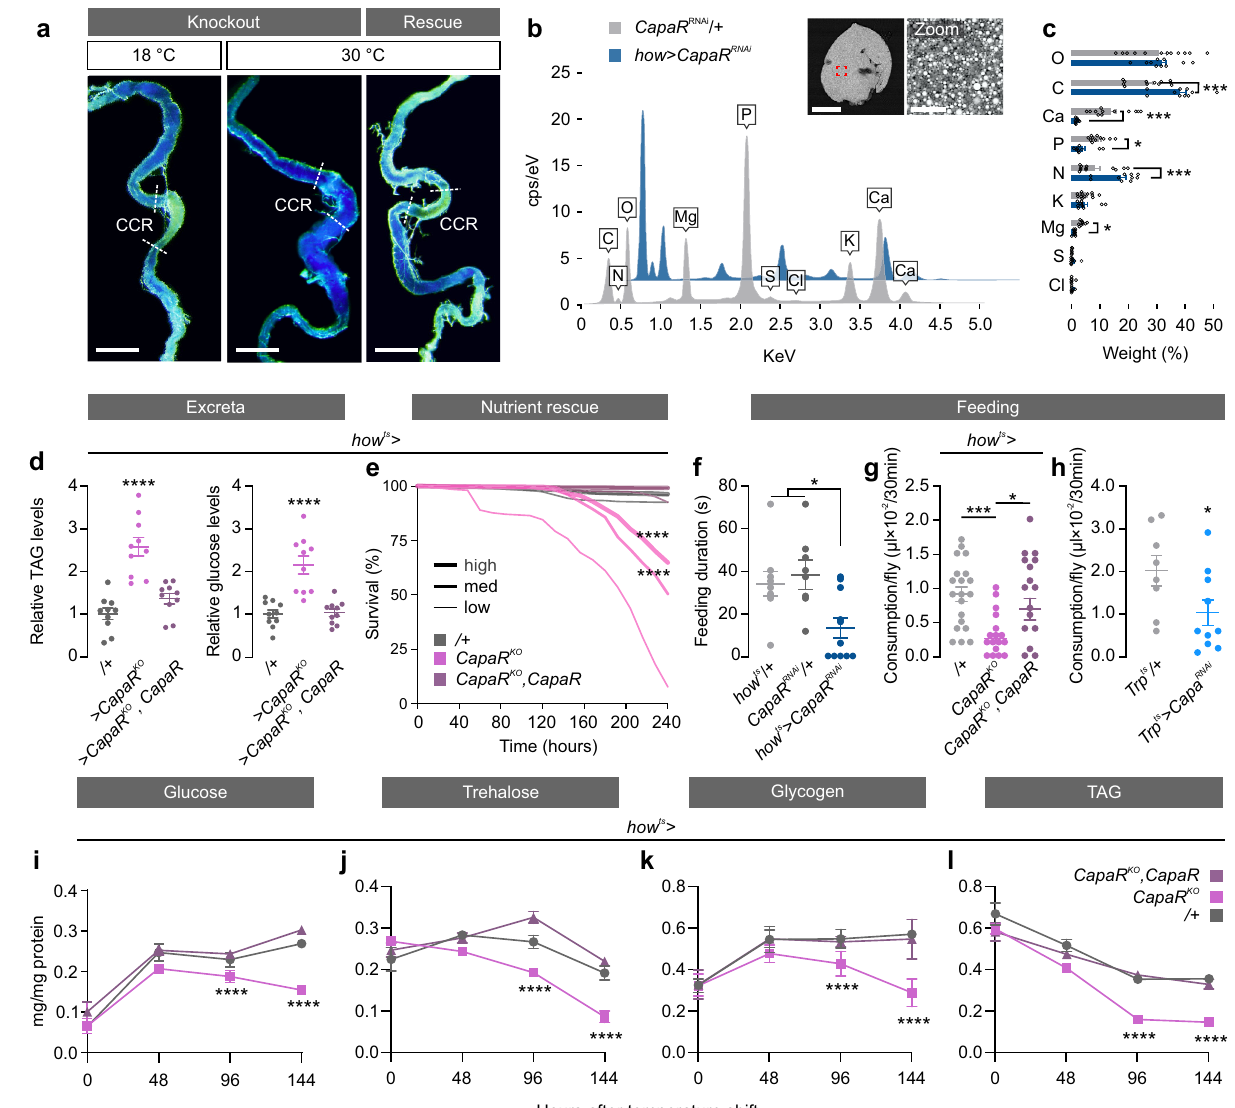
Fig. 5 CapaR deletion in visceral muscles causes systemic metabolic imbalance. a Dissected intestinal tracts from fl ies fed with food supplemented with the pH indicator BPB. A complete loss of acidity in the CCR of the midgut was observed, as evident from the absence of yellowish color, exclusively in how ts >CapaR KO fl ies kept at the restrictive temperature (30°C). This was not detected in animals kept at the permissive temperature (18°C) or in rescue fl ies kept at 30°C additionally carrying a UAS-CapaR transgene ( how ts >CapaR KO ,CapaR ). This experiment was repeated several times with similar results. Scale bar = 200 µ m. b Elemental composition and c weight percentage of each element in the excreta from muscle-speci fi c CapaR -silenced fl ies ( how > CapaR RNAi ; n = 12) relative to control ( CapaR RNAi / + ; n = 10) using scanning electron microscopy coupled with wave-dispersive X-ray analyses (mean±SEM; two-tailed unpaired Student ’ s t -test; C, P = 0.0007; Ca, P <0.001; P, P = 0.002; N, P = 0.0018; Mg, P <0.001). d Relative amounts of undigested triacylglyceride (TAG) and glucose levels in excreta from control ( how ts > + ), knockout ( how ts >CapaR KO ) and rescue ( how ts >CapaR KO ,CapaR ) fl ies raised on standard medium (mean±SEM; one-way-ANOVA; P <0.0001; n = 10). e Flies kept on media with low, medium and high nutrient concentrations show that higher nutrient concentrations reduce mortality in how ts >CapaR KO (low, n = 325; med, n = 323; high, n = 325; P <0.0001) fl ies. Both control (low, n = 272; med, n = 271; high, n = 273) and rescue (low, n = 251; med, n = 250; high, n = 253) fl ies are unaffected by the different nutrient dense diets (two-sided log-rank test; P <0.0001). f Feeding duration in CapaR knockdown animals ( how ts > CapaR RNAi ; n = 11) compared to parental controls ( how ts / + ; n = 9; P = 0.0331: CapaR RNAi / + ; n = 8; P = 0.0120; mean±SEM; one-way ANOVA). g Food intake in CapaR de fi cient ( how ts >CapaR KO ; n = 20) fl ies relative to control ( how ts / + ; n = 20; P = 0.0008), and rescue animals ( how ts > CapaR KO , CapaR ; n = 20; P = 0.0333) as well as in h . Capa silenced ( Trp ts >Capa RNAi ; n = 10) fl ies compared to control ( Trp ts / + ; n = 8; mean±SEM; two-tailed unpaired Student ’ s t -test; P = 0.0480). i – l Quanti fi cation of i glucose, j trehalose, k glycogen and l TAG levels following 48, 96 and 144h of adult-speci fi c transgene activation (mean±SEM; one-way ANOVA; n = 10; P